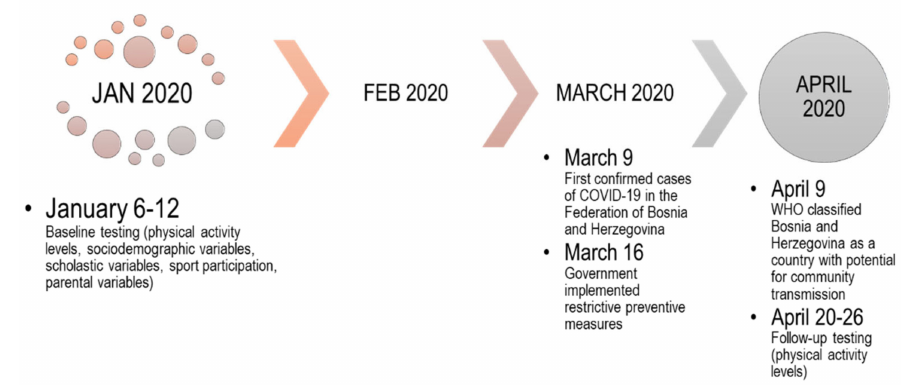
Figure 1. Study protocol and the most important